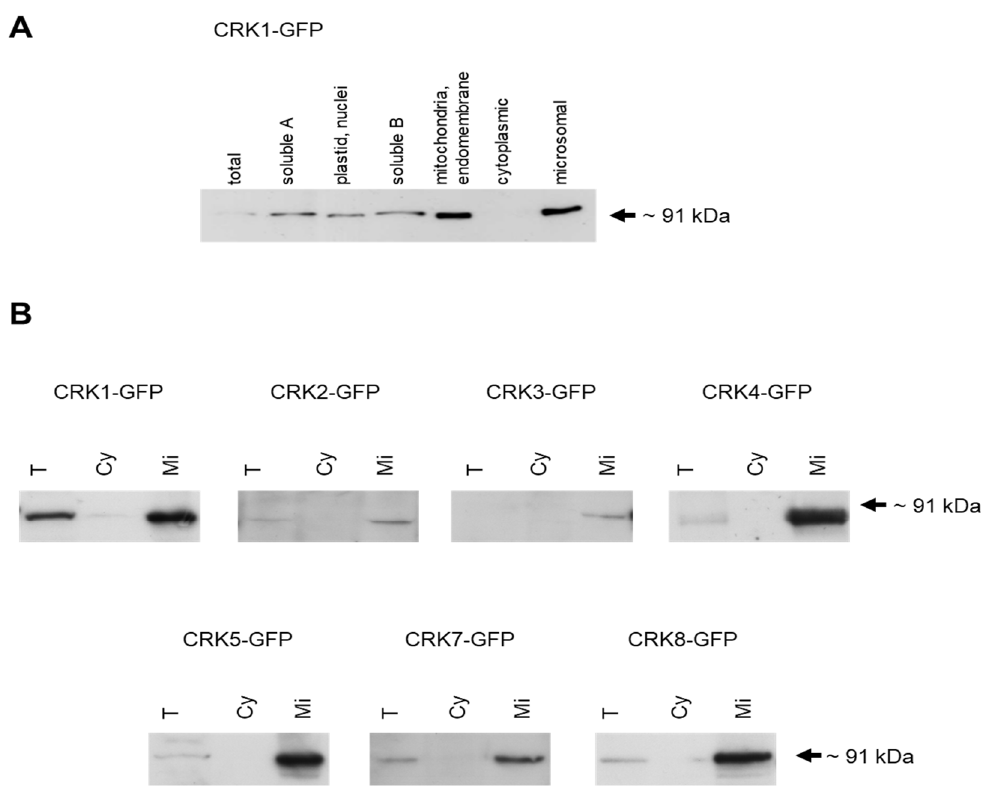
Figure 3. Distribution of AtCRK-GFP proteins in subcellular fractions. Cellular extracts were separated by differential centrifugation and CRK-eGFP was detected by Western hybridization with an antibody recognizing GFP (anti-GFP). Equal amounts of protein (25 µg) were loaded in each lane. ( A ) Identification of AtCRK1-eGFP in six cellular fractions, separated by differential centrifugation; ( B ) Distribution of AtCRK1-eGFP, AtCRK2-eGFP, AtCRK3-eGFP, AtCRK4-eGFP, AtCRK7-eGFP, and AtCRK8-eGFP in two cellular fractions. All AtCRK-eGFP proteins were detected in the microsomal fractions and but not in the cytoplasmic soluble fractions. T: total protein extract, Cy: cytoplasmic soluble, Mi: microsomal membrane fraction.